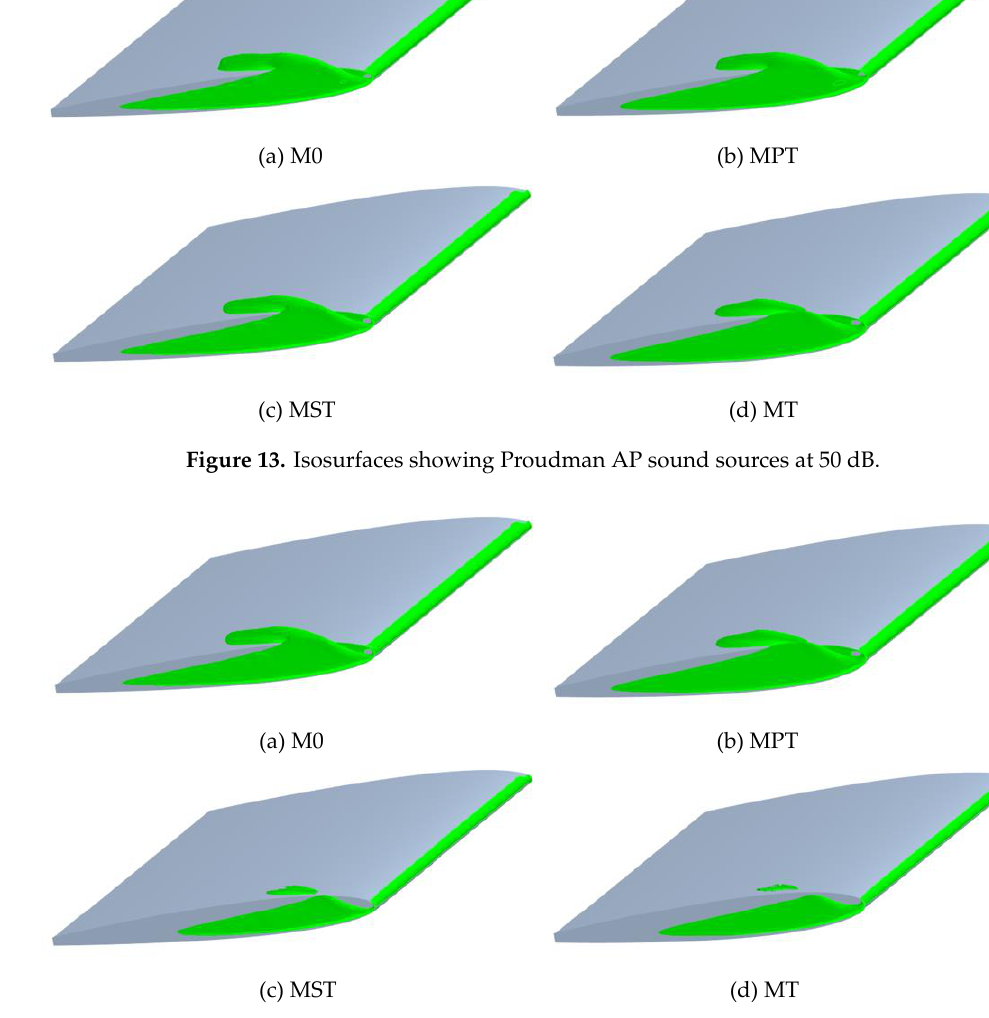
Figure 14. Isosurfaces showing Proudman AP sound sources at 55 dB.